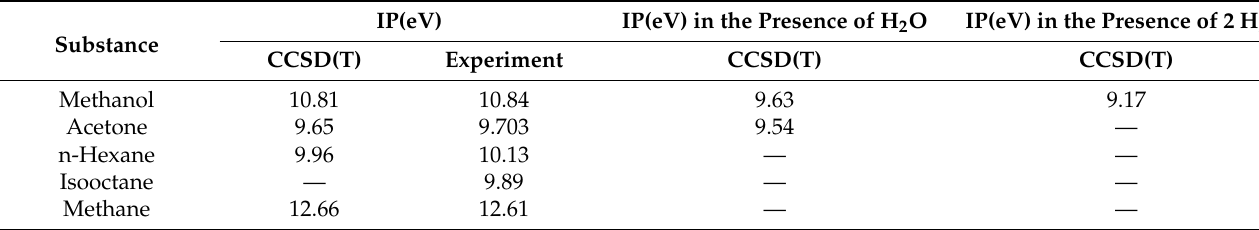
Table 3. Ionization potential (eV) computed at the CCSD(T)/aug-cc-pVTZ//B3LYP/aug-cc-pVTZ level of theory at 298.15 K for the investigated molecules. Experimental values [25] are reported for comparison.